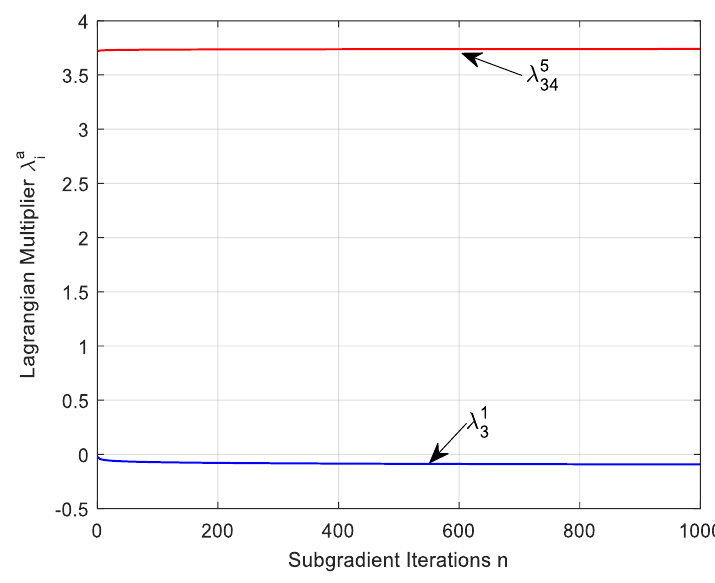
Figure 7. Convergence of Lagrange multiplier versus proximal n.